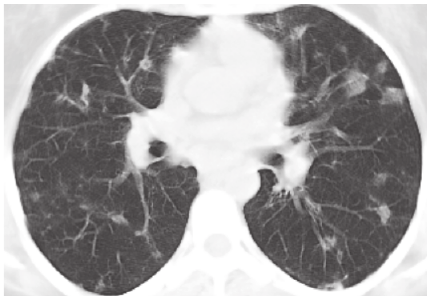
Figure 1: Thoracic computerized tomography showed bilateral, irregularly bordered, multiple ground-glass pulmonary nodules with diameters ranging from a few millimeters to 20 mm and, additionally, patchy ground-glass areas were detected.